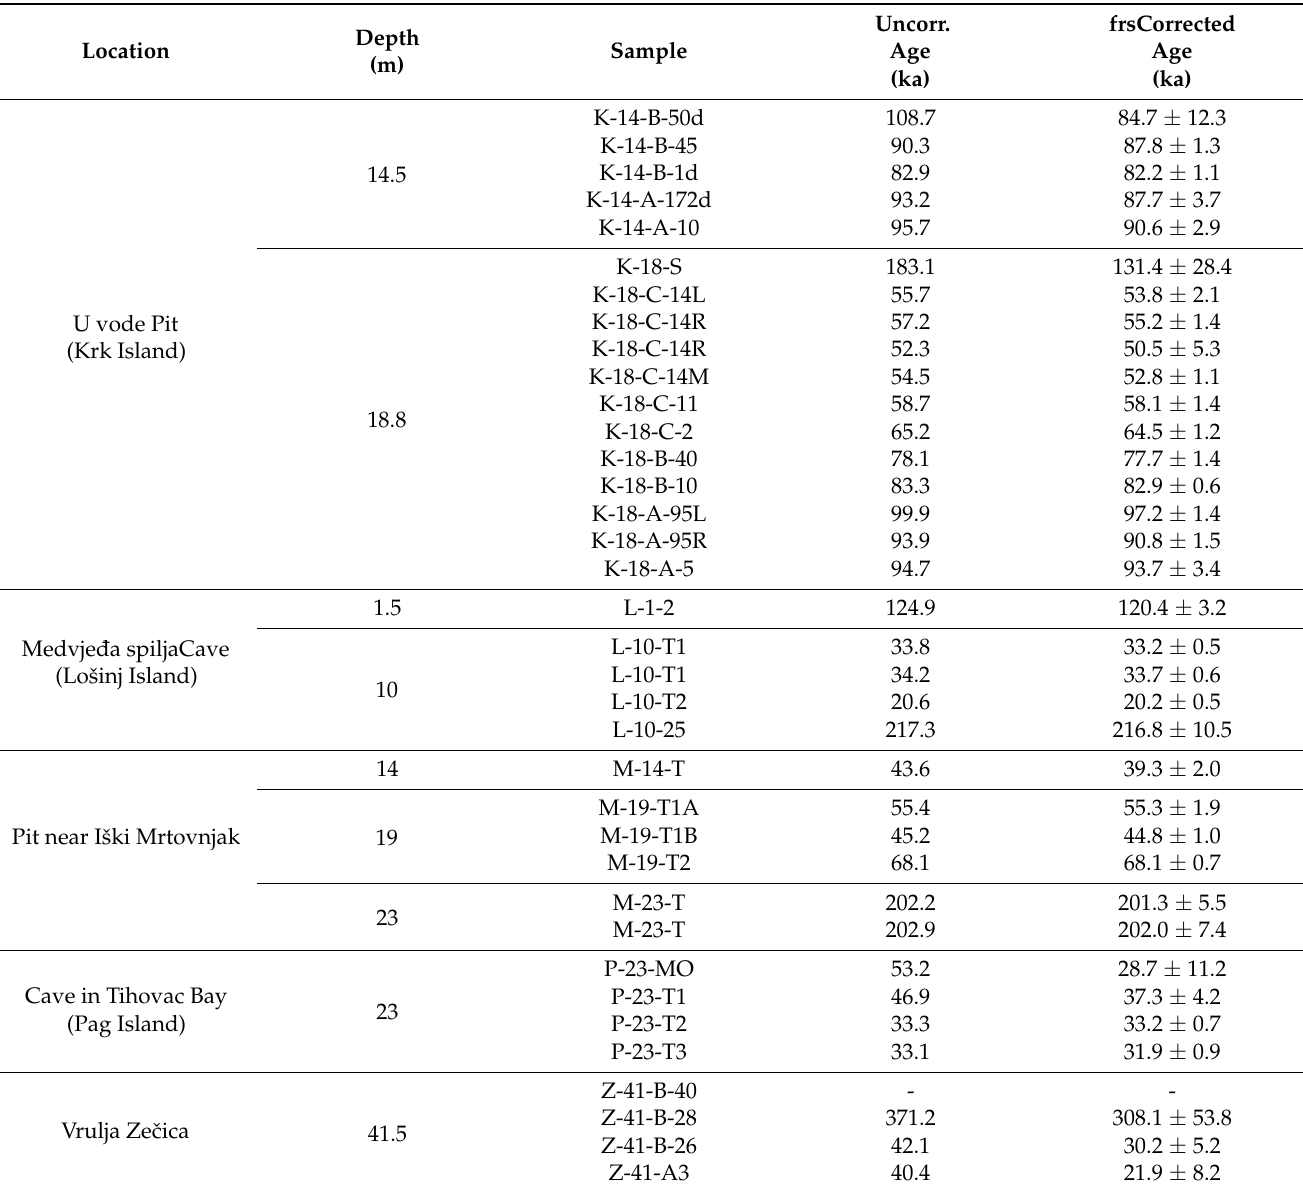
Table 4. Location, depth, sample code, U-Th, and radiocarbon ages of the speleothem studied in Croatia (also see Figure 3). 14 C ages of speleothems L-1 and L-10 measured through liquid scintillation counting and speleothems Z-41, B-38, B-36, B-34, B-28, P-23, and R-21 measured by an alpha proportional counter. The youngest parts are marked with an A and S, while B refers to the oldest parts. 14 C ages are expressed as conventional 14 C corrected for A 0 = 85% and measured δ 13 C ( − 8‰ when not measured), and as calibrated ages. From